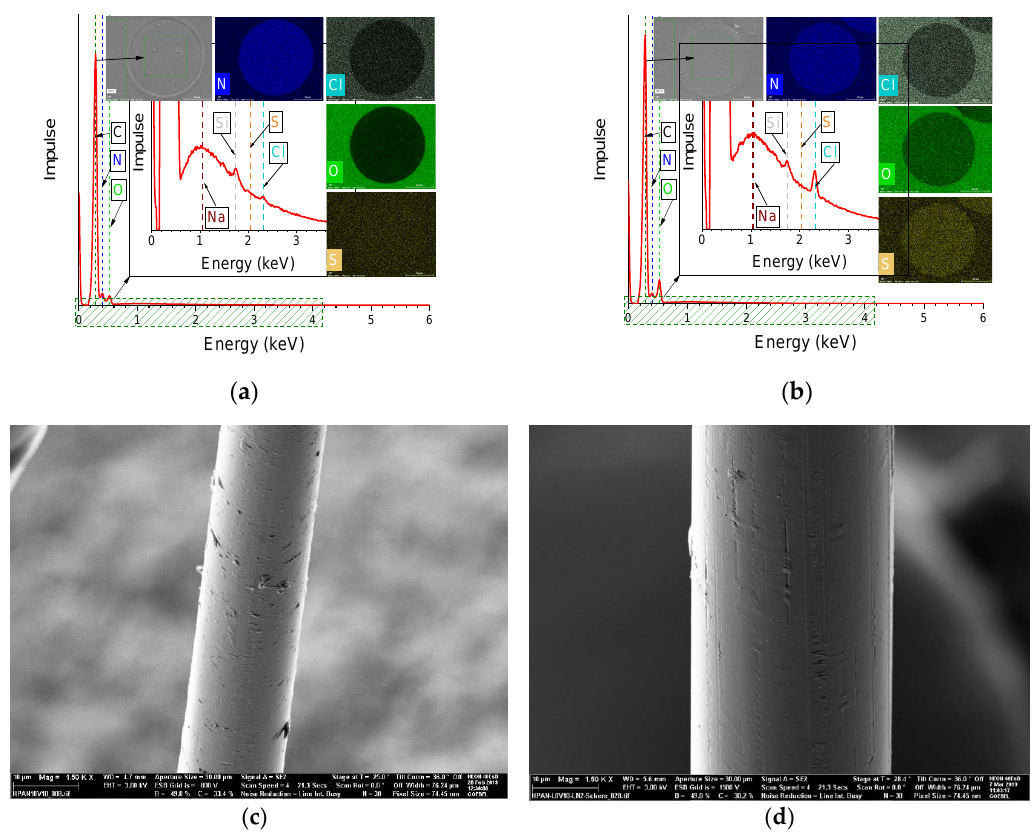
Figure 11. (a ) EDX analysis of PAN fibers at (DR = 4) and ( b ) EDX curves of PAN/lignin fibers (DR = 4); ( c ) SEM image of the surface of PAN fibers (DR = 10); and ( d ) SEM image of the surface of PAN/lignin fibers (DR = 10).